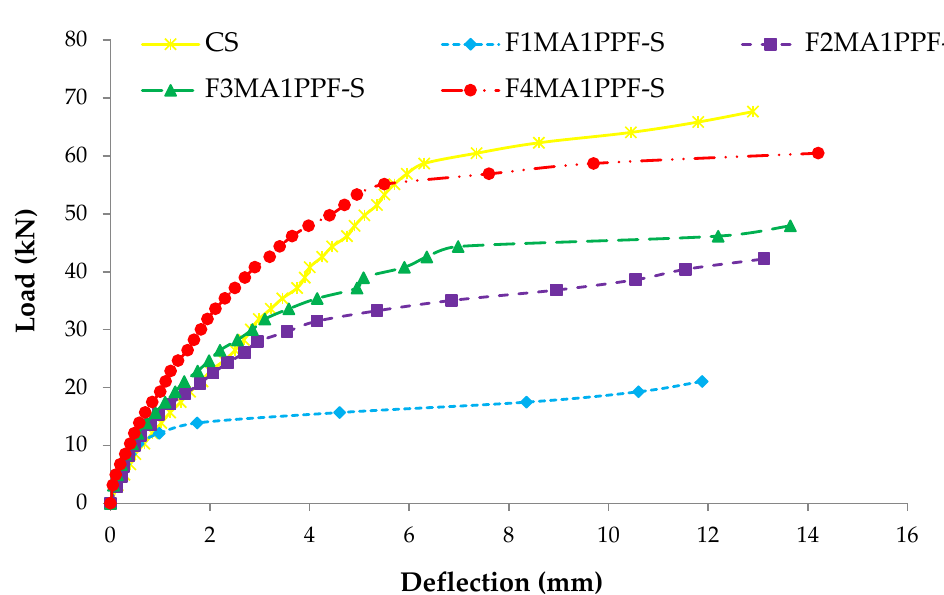
Figure 11. Comparison of load-deflection of group A1 with CS slab.